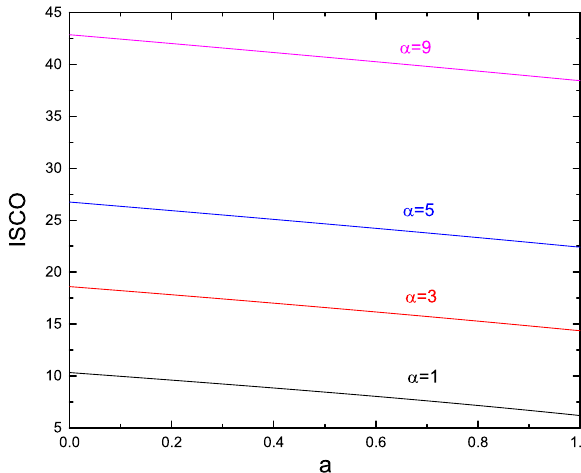
Fig. 11 ISCOs of Kerr-MOG black holes. ISCOs are plotted on some intrinsic angular momentum a and parameter α . The solid line is the case of the Kerr black hole. The ISCO of the Kerr black hole converges to 1 at a = 1, while the ISCO of the Kerr-MOG case is not. Thus, for rapidlyspinningblackholes ( a > 1 ) ,thereisanISCOintheKerr-MOG case